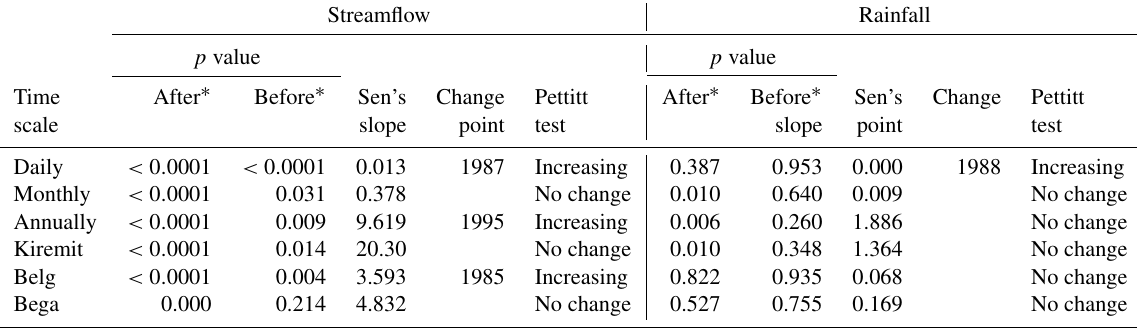
Table 3. MK and Pettitt tests for the UBNRB’s rainfall and streamflow after TFPW at different timescales.